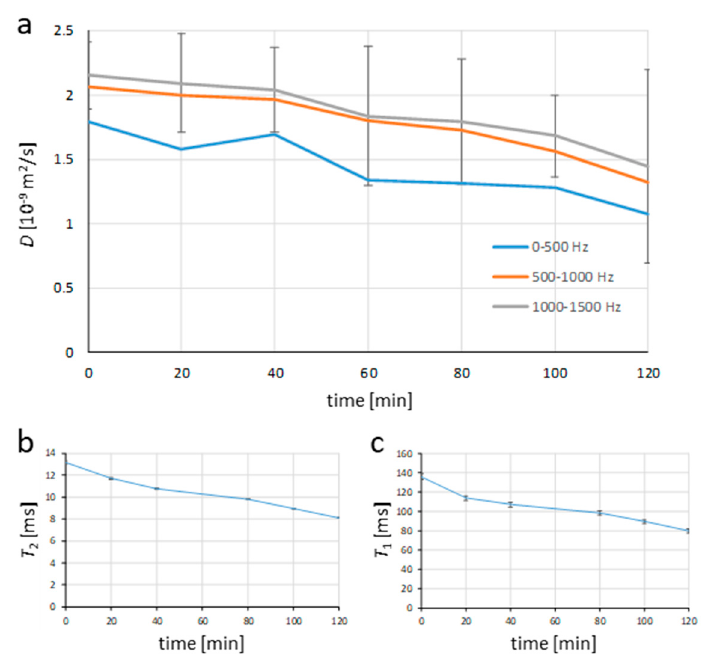
Figure 3. Cement hydration process followed by time courses of ( a ) diffusion, ( b ) transversal NMR relaxation time, and ( c ) longitudinal NMR relaxation time. Diffusion was followed for three different frequency regimes: low, with frequencies up to 500 Hz, medium, with frequencies between 500 and 1000 Hz and high, with frequencies between 1000 and 1500 Hz.